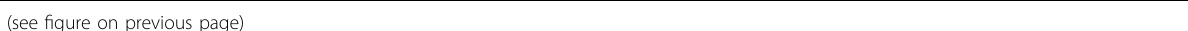
(see fi gure on previous page) Fig. 2 DBD is required for PPAR γ phase separation. a Turbidity assay was used to quantify phase separation of PPAR γ truncations (10 μ mol/L protein, 150 μ mol/L NaCl, 10% PEG-8000). OD600 was normalized to the measurement of mEGFP control ( n = 3). Data are shown as means ± SEM. Top, a schematic representation of the PPAR γ domains. b Representative fl uorescence microscopy images of truncated forms of PPAR γ -FL (10 μ mol/L protein, 150 μ mol/L NaCl, 10% PEG-8000). c Phase diagram of PPAR γ -DBD in the presence of different concentrations of NaCl, displaying that phase separation potential of the protein is dependent on salt concentration (10% PEG-8000). d Turbidity assay was used to quantify phase separation of DBD truncated forms of PPAR γ -FL (10 μ mol/L protein, 150 μ mol/L NaCl, 10% PEG-8000). OD600 was normalized to the measurement of mEGFP control ( n = 3). Data were shown as means ± SEM. Top, a schematic diagram showing PPAR γ with DBD truncated (top) and recombinant mEGFP fusion protein used here (bottom). e Representative fl uorescence microscopy images for condensate formation of PPAR γ truncations. Cells were transfected with PPAR γ truncations for 48 h and imaged, respectively. f The disruption of zinc fi nger motif impaired the PPAR γ phase separation. Representative images of wild-type PPAR γ or PPAR γ with the disruption of zinc fi nger motif (PPAR γ C>A) fused to mEGFP in droplet formation assay (5 μ mol/L protein, 150 μ mol/L NaCl, 10% PEG-8000). All cysteines in zinc fi nger motif were mutated to alanines. g Column scatter charts display average droplet area of each image related to Fig. 2f. Data are shown as means ± SEM ( n = 10). h Representative fl uorescence microscopy images of a mixture of mEGFP-PPAR γ -DBD/mCherry, mEGFP/mCherry-RXR α , mEGFP-PPAR γ -DBD/mCherry-RXR α , and mEGFP-PPAR γ -LBD/mCherry-RXR α respectively (2 μ mol/L protein, 150 μ mol/L NaCl, 10% PEG-8000). Scale bar, 5 μ m. i Column scatter charts display the droplet diameter in reactions related to panel h . Data are shown as means ± SEM ( n = 500). j Phase diagram of PPAR γ -DBD in the presence of different concentrations of RXR α (150 μ mol/L NaCl, 10% PEG-8000). One-way analysis of variance (ANOVA) for panels a , d, and i . Two-tailed unpaired t -test for panel g . *P < 0.05, ** P < 0.01, *** P < 0.001, **** P < 0.0001. ns, not signi fi